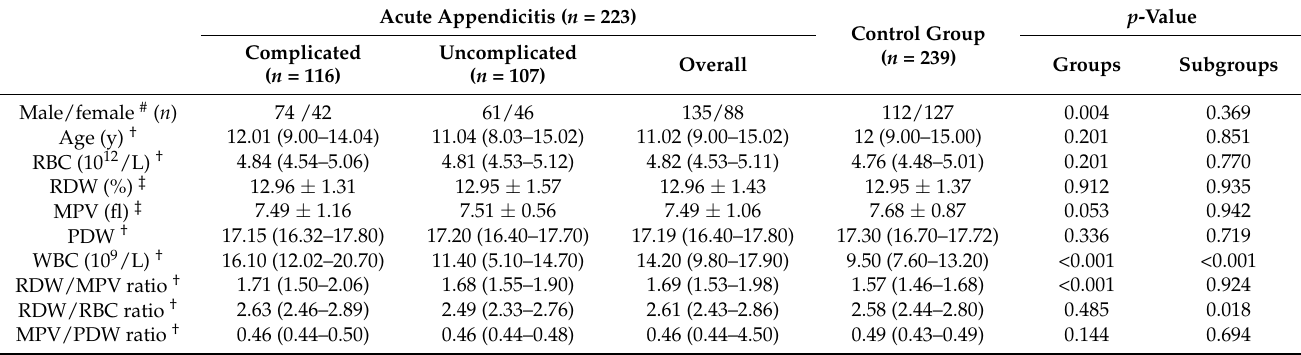
Table 1. Demographic and laboratory data within groups and